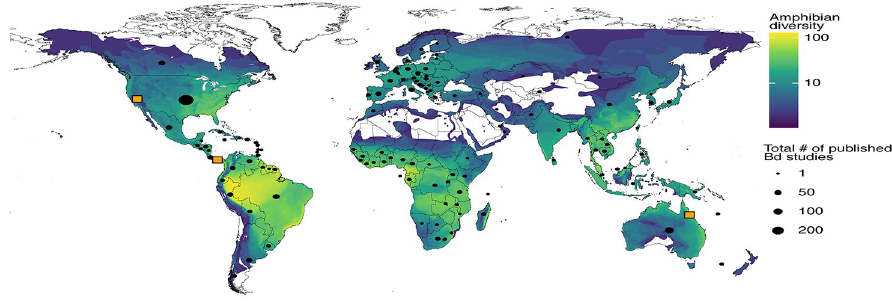
Fig 1. Global map of amphibian diversity (i.e., number of species), the number of Bd studies published per country, and locations with species data before and after a Bd-related chytridiomycosis epizootic. Orange squares show the worldwide locations of studies that contain data on amphibians as well as other taxonomic groups before and after Bd invasion. Amphibian biodiversity data were obtained from [49] and the number of published Bd studies per country was tabulated from